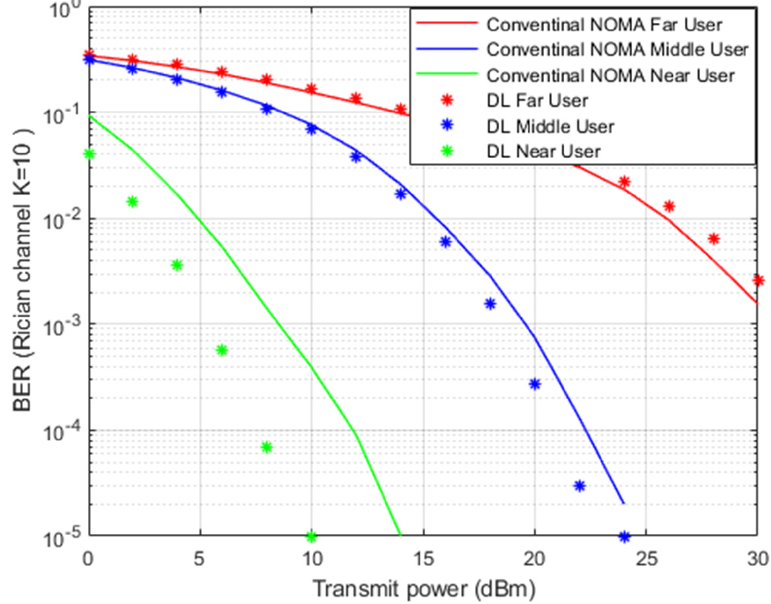
Figure 8. BER vs. power-based DL and conventional NOMA (Rician Channel).